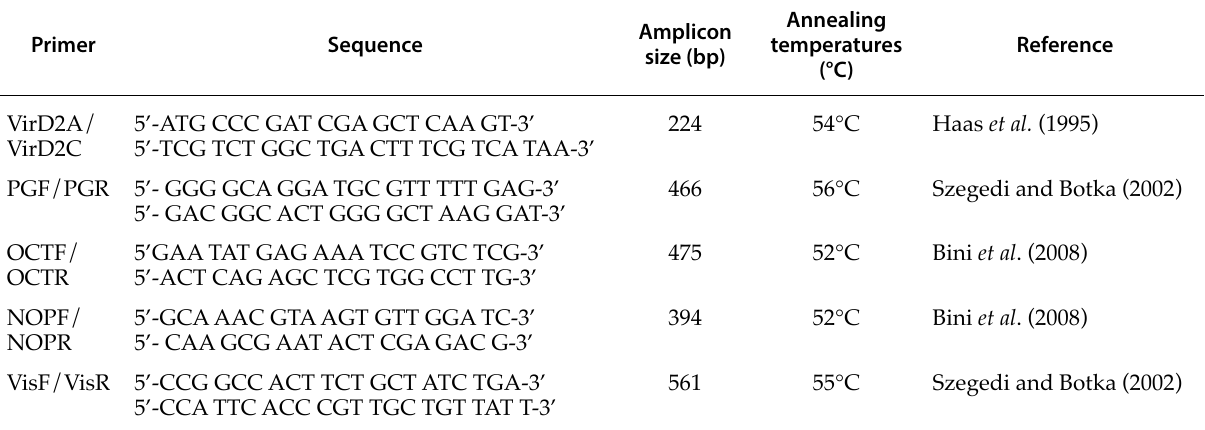
Table 2. Primer pairs used for differentiating Rhizobium spp. and for determining opine type.